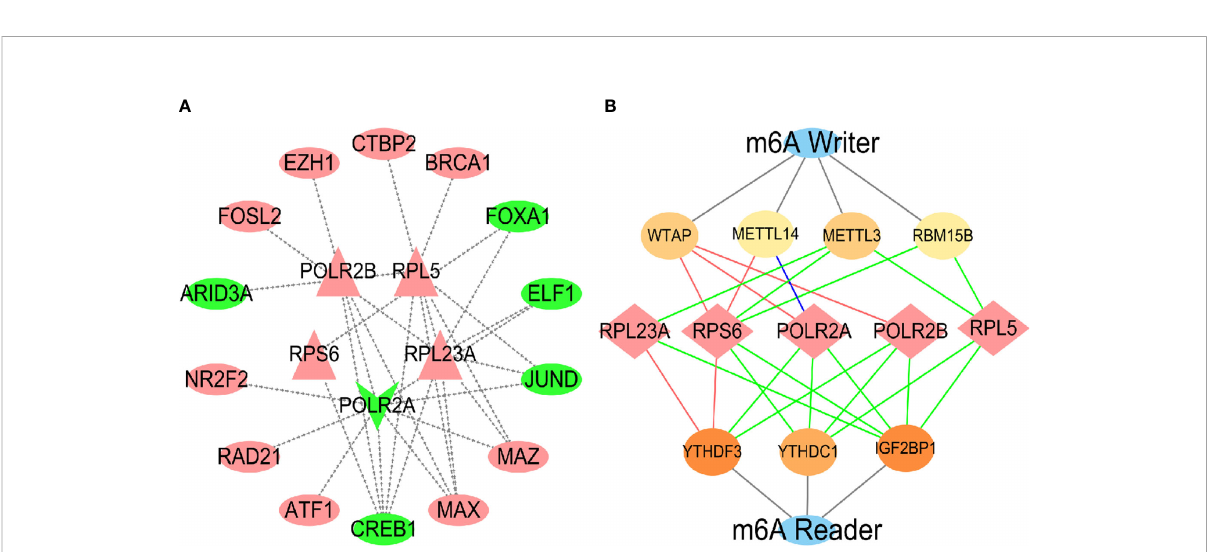
FIGURE 11 Prediction and validation of TF and m 6 A enzymes. In the TFs regulatory network (A) , the inside is the central gene, and the outside is the transcription factor. Red represents up-regulation, and green represents down-regulation. In the m 6 A regulatory nerwork (B) , the red lines represented protein- protein interactions, the green lines represented protein-RNA interactions, and the blue lines represented protein DNA interactions.